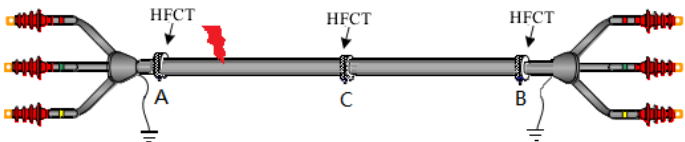
Figure 1. Multi-sensor installation. Three sensors A, B, and C are installed on the cable body, where A and B are located at both ends of the measurement interval, and C is located at the midpoint of the AB segment. HFCT: high-frequency current sensor.